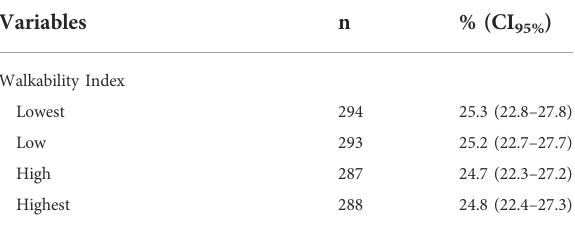
TABLE1( Continued )CharacteristicsoftheparticipantsoftheEpiFloripa Aging Study. Florianopolis, Brazil, 2017 – 2019 (n = 1,162).